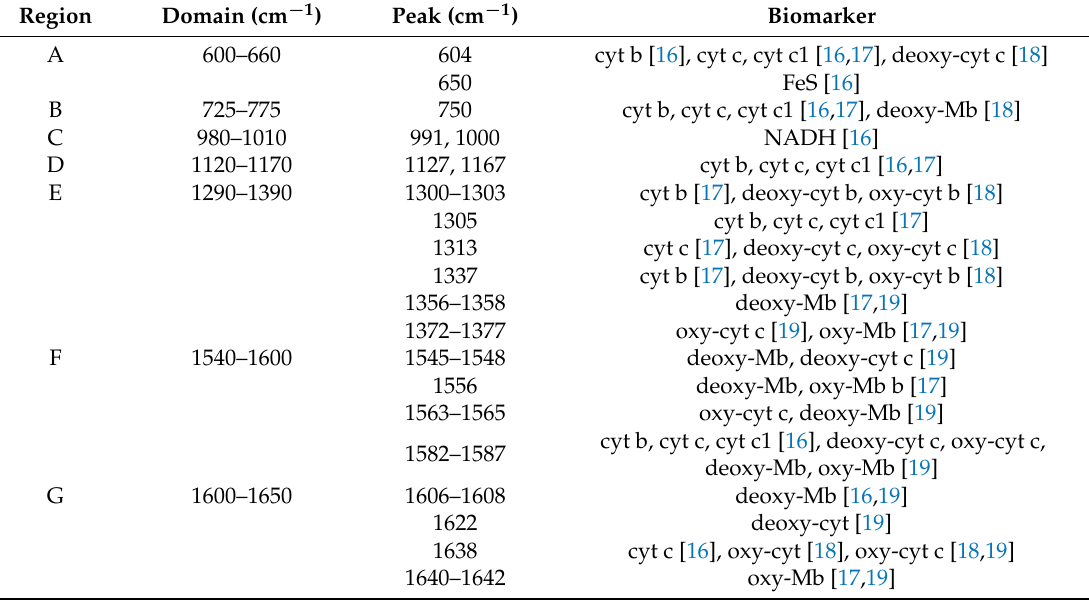
Table 2. Regions with known biomarkers used in t -test.